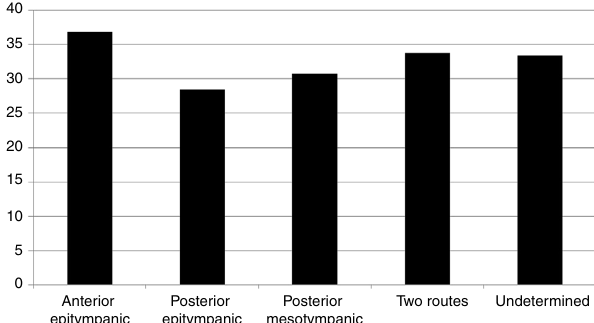
Figure 4 Comparison of tritonal means of air-bone gap (dB) between the different routes of cholesteatoma